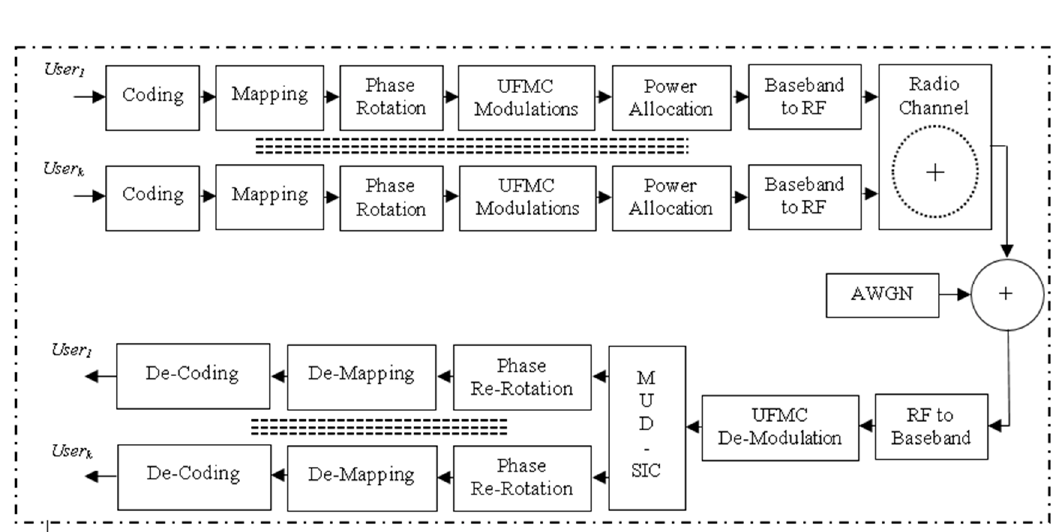
Figure 2. Proposed uplink multi-carrier waveform design.